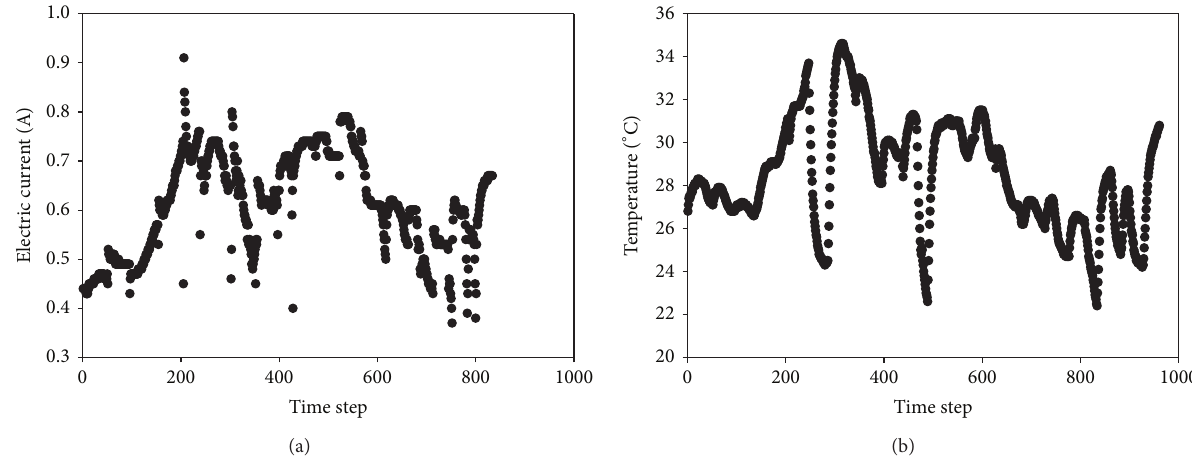
Figure 9: Comparing variations of electric current with soil temperature: (a) current; (b)